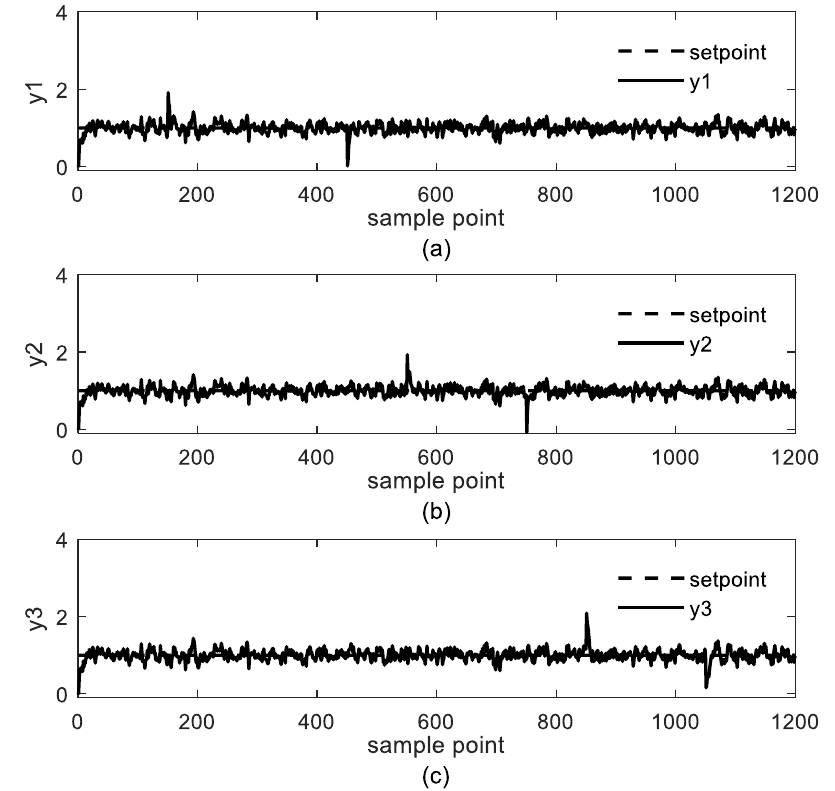
Figure 18. The simulation result of OSDP2 with white noise: ( a ) y 1 —production; ( b ) y 2 —slurry polymer; ( c ) y 3 —catalyst efficiency.